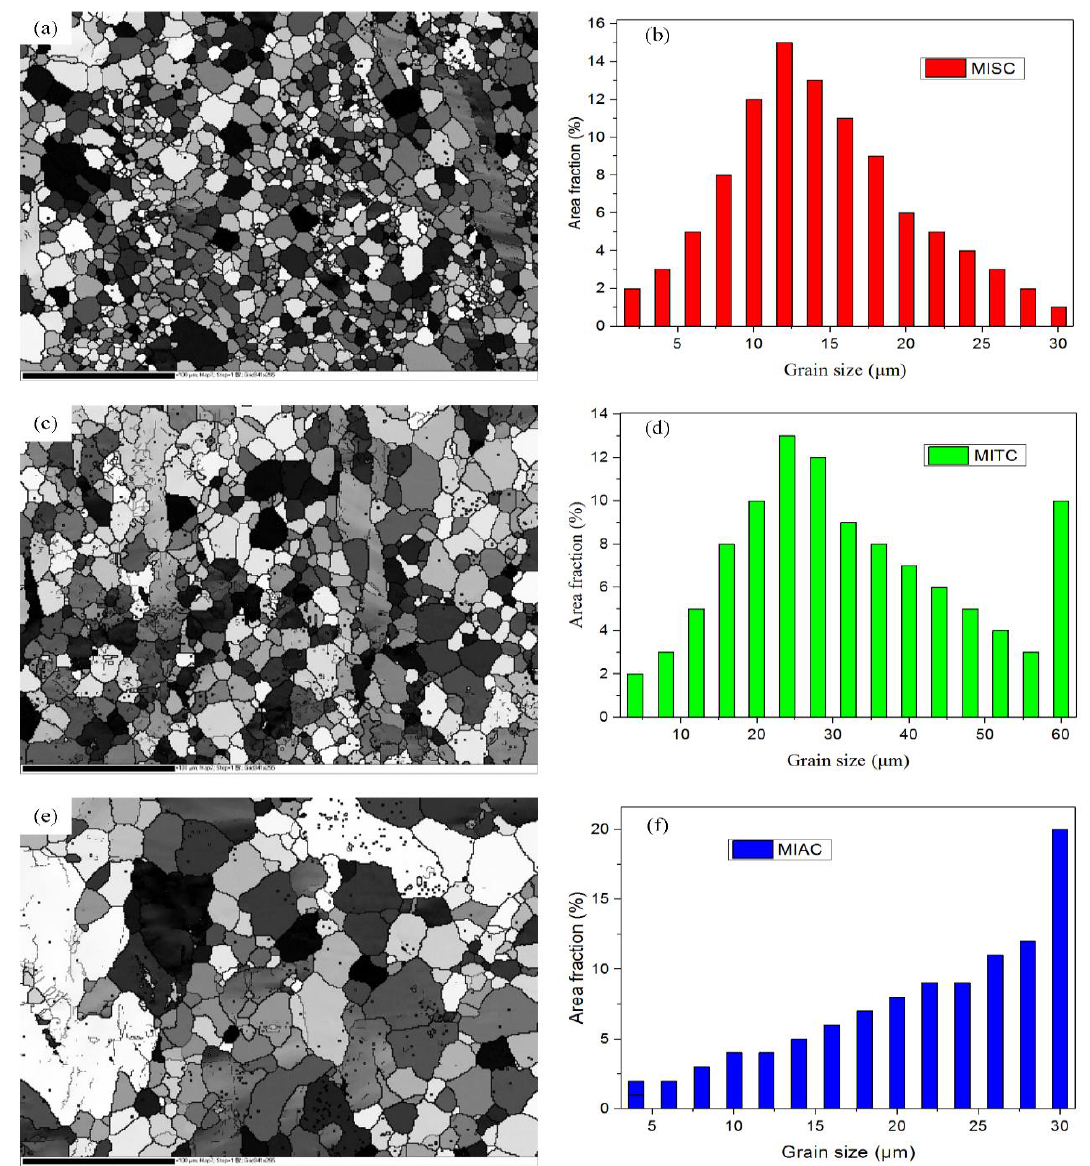
Figure 7. The SEM and the grain size distributions of magnesium matrix composite in three kinds of reinforcement as-extruded states: ( a , b ) MISC; ( c , d ) MITC; ( e , f ) MIAC.